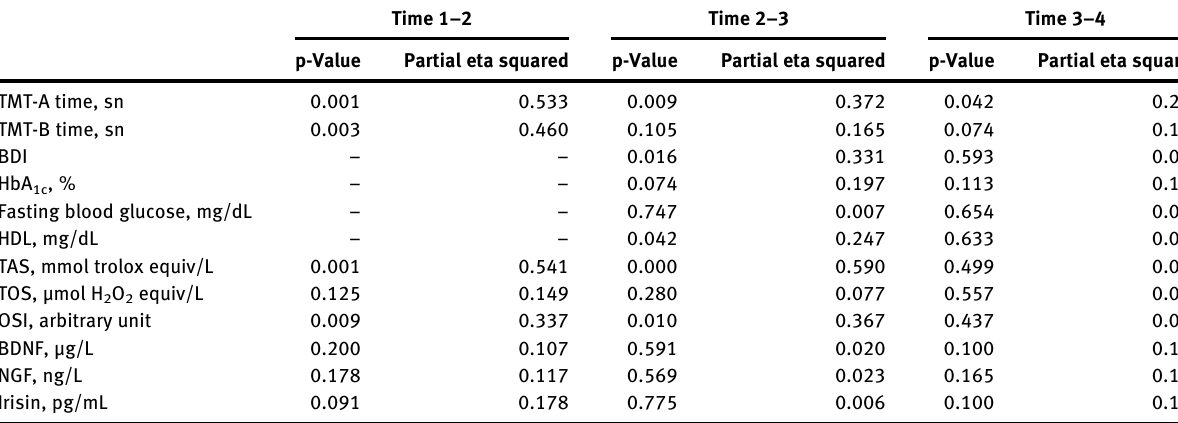
Table  : Time-dependent changes in results.